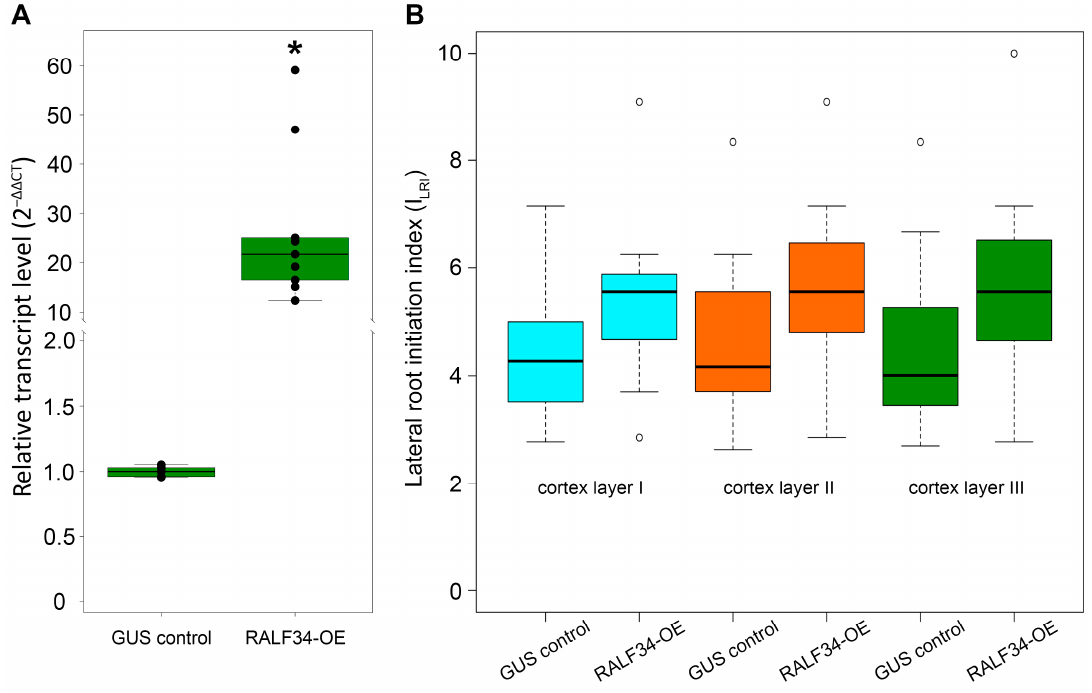
Figure 1. Overexpression of Cucumis sativus RALF34 in transgenic roots. ( A ) Expression of CsRALF34 in control roots (GUS control) and in roots with an overexpression construct (RALF34-OE). RT-qPCR analysis was performed using RNA isolated from the control group (mix of roots) and from individual transgenic roots. Statistical analysis using Wilcoxon’s signed-rank test showed a significant increase (*, p < 0.001) of expression levels in the overexpression group compared with the control. The y -axis indicates the relative transcript level (2 – ΔΔ CT method). ( B ) The Lateral Root Initiation Index in three outer cortical layers of control roots (GUS control) and of roots overexpressing RALF34 (RALF34-OE). Statistical analysis using Wilcoxon’s signed-rank test showed no significant differences ( p > 0.05) in the I LRI of individual roots in the overexpression group compared with control roots.